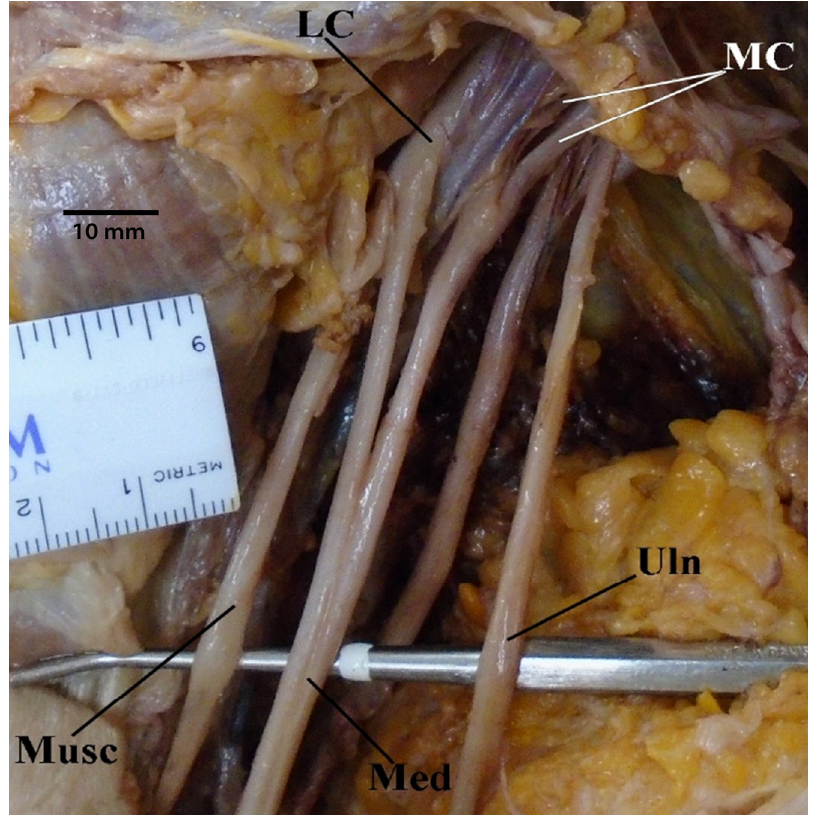
Figure 3. Photograph of the anatomical variant in which the median nerve is formed by two branches from medial cord and one branch from lateral cord. Abbreviations: LC = lateral cord; MC = medial cord; Med = median nerve; Musc = musculocutaneous nerve; Uln = ulnar nerve. Two other frequent atypical branching patterns involved the musculocutaneous nerve. Nine examples were found of the musculocutaneous nerve not piercing through coracobrachialis and the nerve route was much longer than normal; instead, the nerve pierced through brachialis and/or biceps brachii muscle (Figure 4). The other disparity pertaining to the musculocutaneous nerve was multiple proximal branches of this nerve emanating prior to the nerve diving into the anterior arm muscles, which was also noted on nine separate occasions (Figure 5).